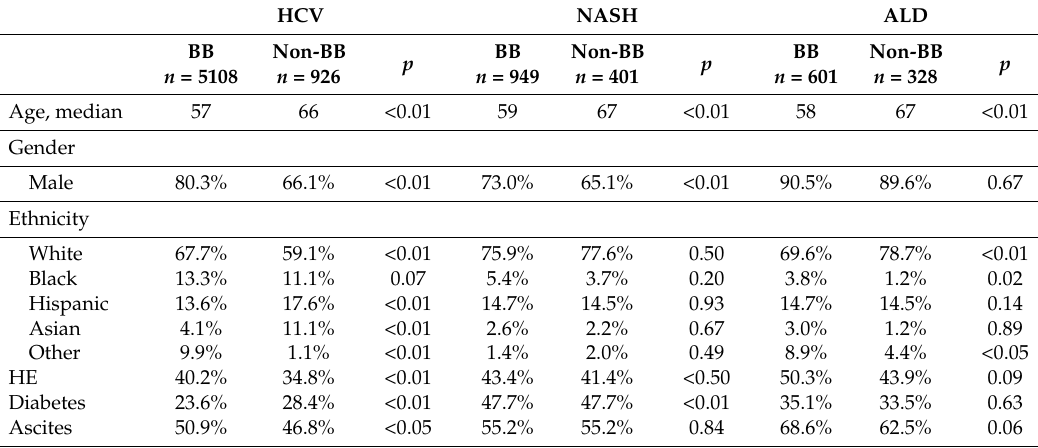
Table 2. Demographic and Clinical Characteristics in HCC Liver Transplant Recipients among Baby Boomers versus Non-Baby Boomers; UNOS